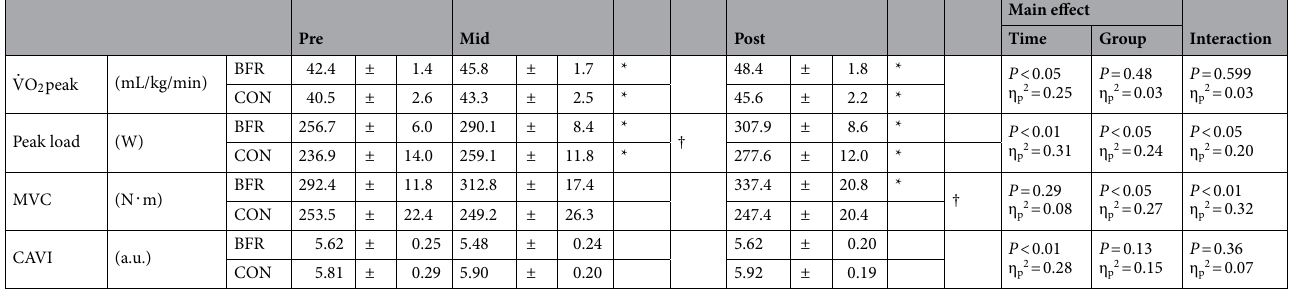
Table 3 shows that there were no significant effects of BFR cycle training on coagulation and fibrinolytic vari- ables. While TAT and t-PAIC did not significantly change from Pre- to Post-training, D-dimer levels significantly decreased from Pre- to Post-training in both groups after 8 weeks of training.